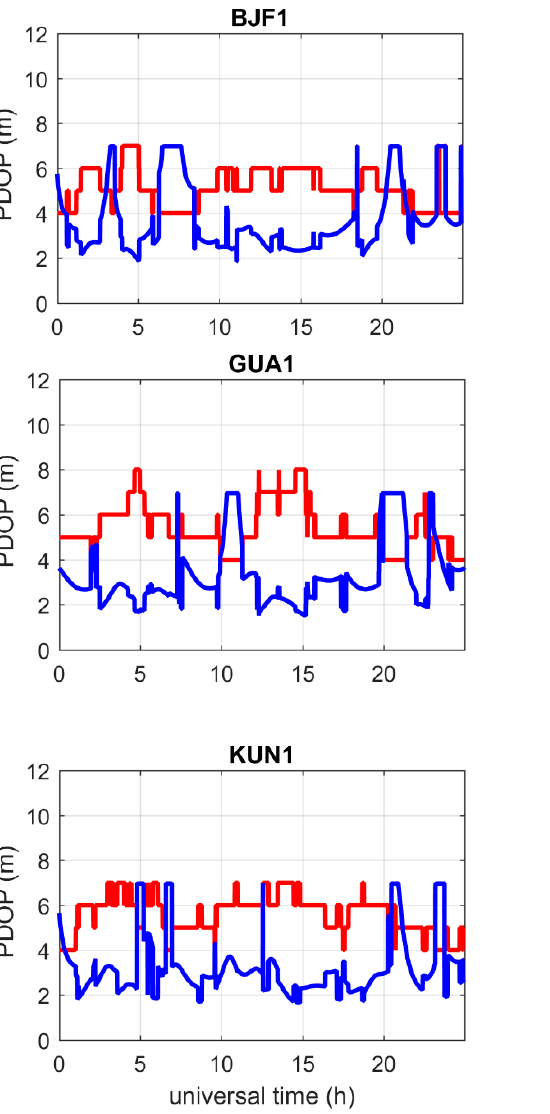
Figure 14. The visible BDS-3 satellites number and PDOP of the six selected stations on DOY 92, 2020.